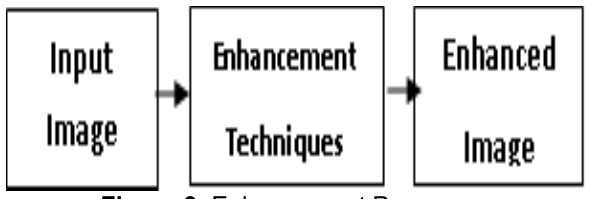
Figure 3. Enhancement